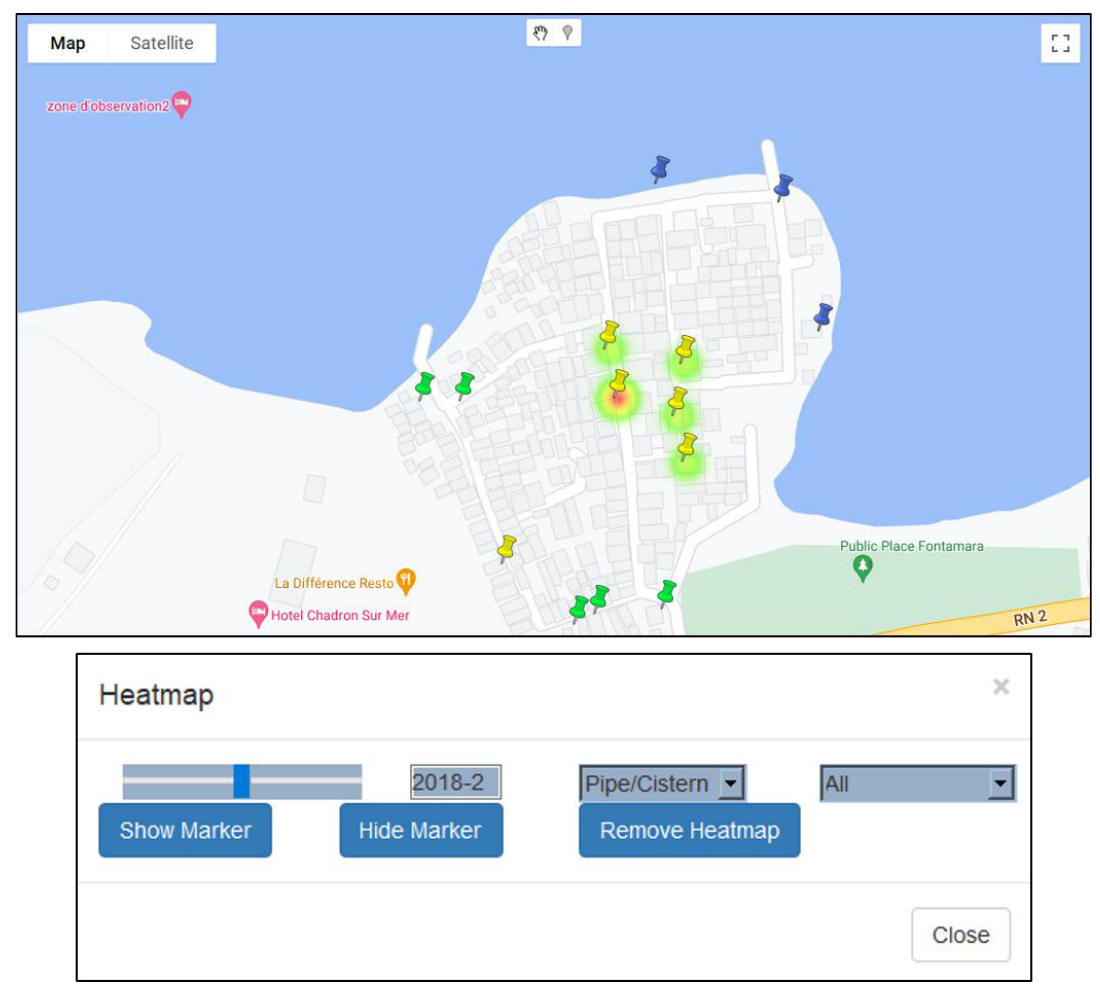
Figure 7. Heatmap displaying the overall spatial distribution of epidemiological records.